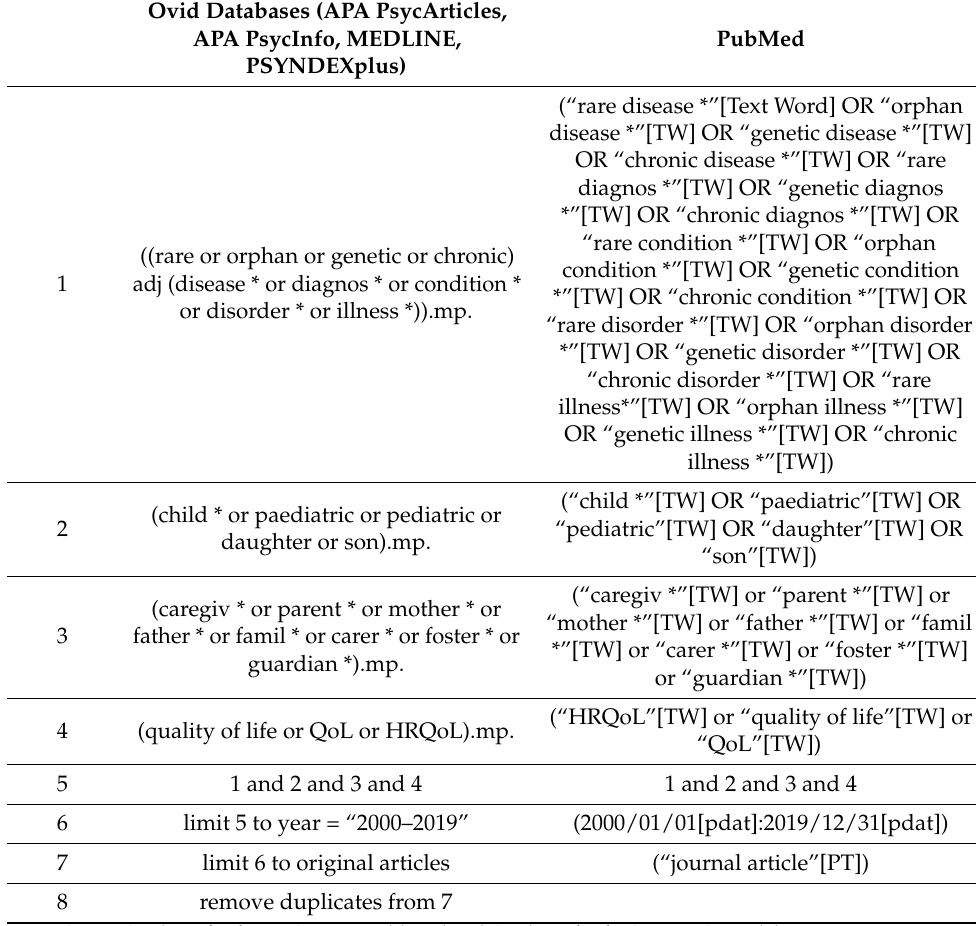
Table 1. Search strategies. Ovid Databases (APA PsycArticles, APA PsycInfo,